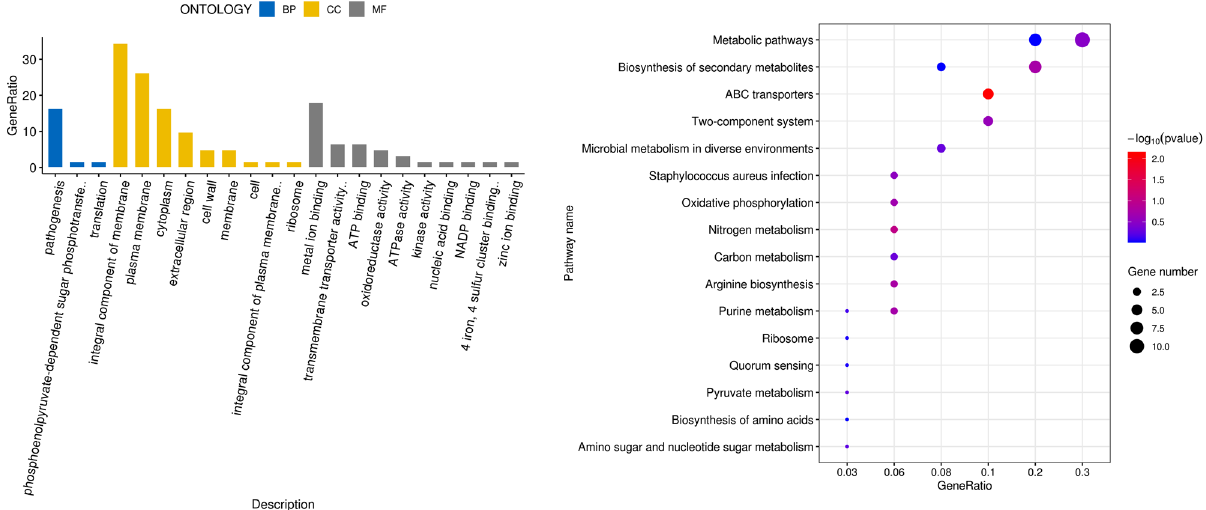
Figure 2. Functional and signaling pathway analysis of the overlapped DEGs according to BP, CC, MF, and KEGG pathways.